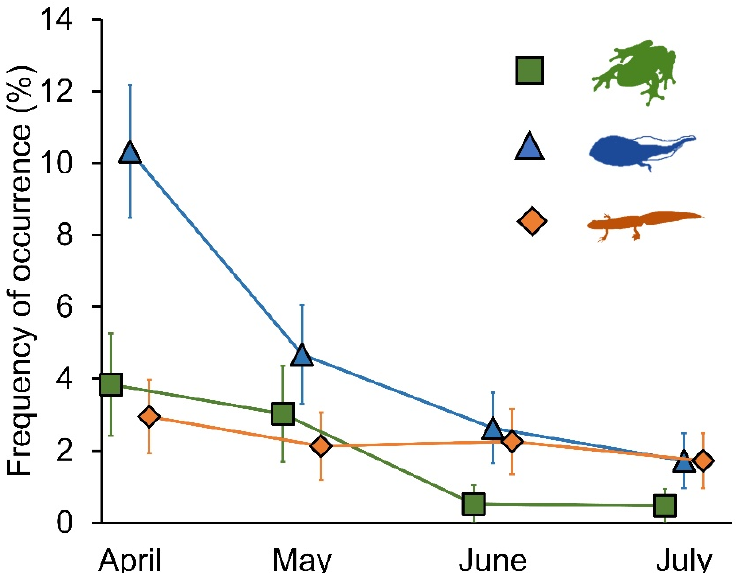
Figure 3. Monthly frequency of occurrence of amphibians in stomach contents of marsh frogs ( n = 1062). Green lines and squares: metamorphosed anurans; blue lines and triangles: tadpoles; orange lines and diamonds: newts. Whiskers: SE.